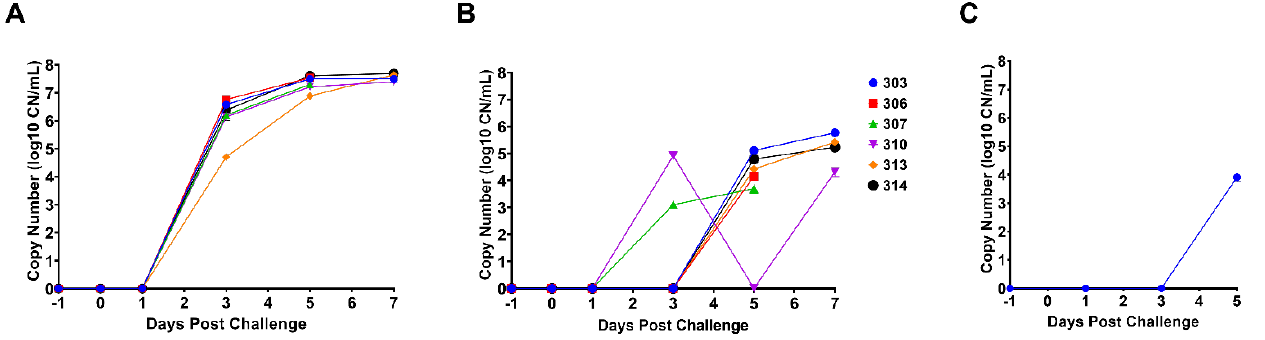
Figure 4. Quantitative real-time PCR for ASFV DNA detected in blood, OP swabs, and oral fluids. ( A ) The calculated copy number (CN) of ASFV DNA extracted from EDTA blood collected on −1 , 1, 3, 5, and 7 DPC using a ten-point standard curve. Datapoints for individual pigs are represented. The single data point at 6 DPC represents blood collected from pig #306, which was found dead. ( B ) The calculated copy number of ASFV DNA extracted from OP swabs collected on −1 , 1, 3, 5, and 7 DPC using a ten-point standard curve. Datapoints for individual pigs are represented. ( C ) The calculated copy number of ASFV DNA extracted from oral fluids (rope chewing) collected on −1 , 1, 3, and 5 DPC using a ten-point standard curve. Datapoints represent the pen level.